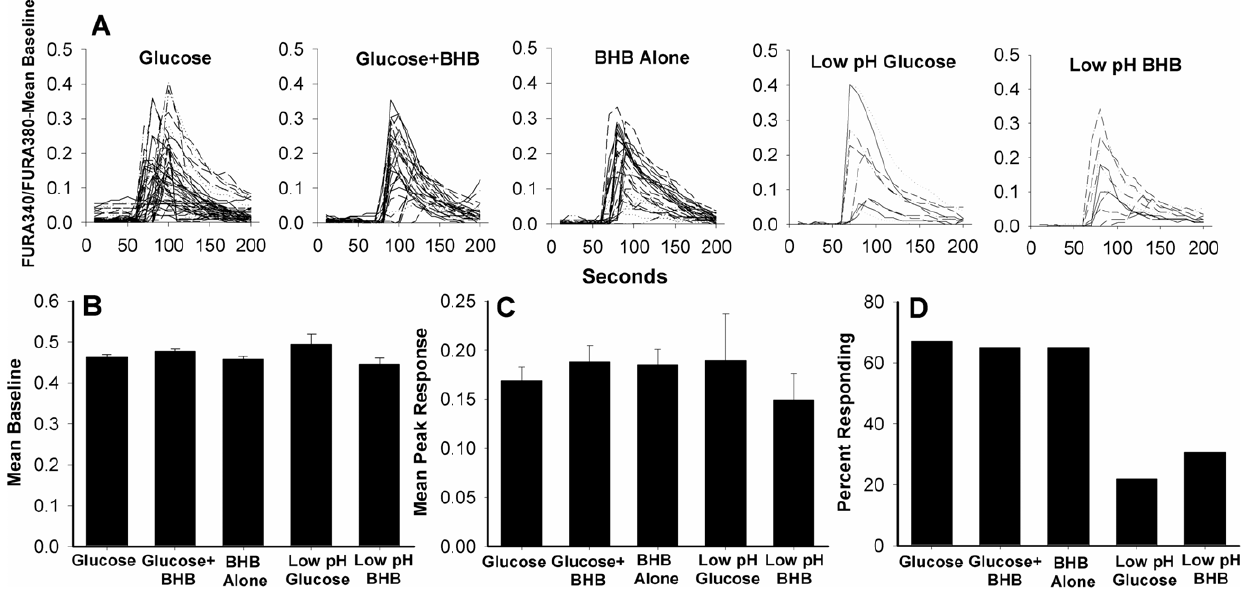
Figure 1. Muscimol-induced calcium influx in BHB-treated hippocampal cultured neurons. A. Traces of muscimol-induced calcium responses in immature dispersed hippocampal neurons with glucose alone, ketone bodies (BHB) with glucose, or BHB alone. The last two top panels are traces from cells tested with experimental solutions with a lower pH. Addition of BHB to perfusates did not reduce muscimol-induced calcium influx. B. Ketone bodies did not change the average baseline or C. the average peak in [Ca2 + ]I in response to the GABA-A agonist muscimol. Error bars represent the standard error of the mean. D. Percentage of cells responding in each condition. Lowering the pH significantly decreased the number of cells exhibiting excitatory responses to muscimol.